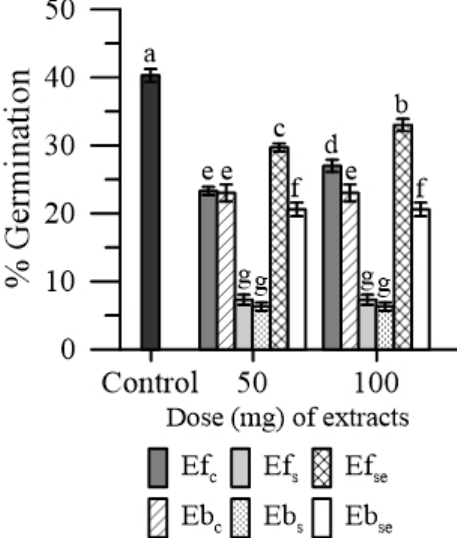
Figure 4. Germination of maize pollen in the presence of 50 or 100 mg of free (Ef) and bound (Eb) extracts of emmer wheatgrass grown with distilled water as a control (Ef c , Eb c ), or in the presence of salinity as NaCl 50 mM (Ef s , Eb s ) or selenium as 45 mg L − 1 of Na 2 SeO 3 (Ef Se , Eb Se ). Data are ex ‐ pressed as means ± SEM from five independent tests. Different letters indicate significant differences for p < 0.05.